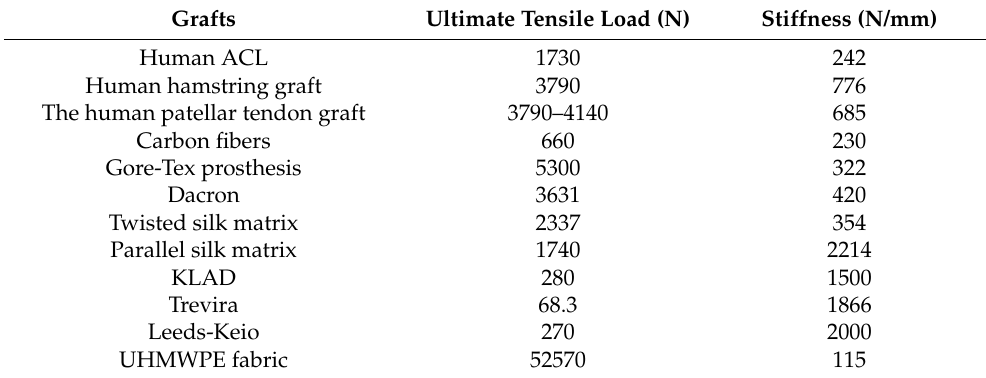
Table 12. Mechanical properties of materials for synthetic grafts compared to normal ACL [168]. Grafts Ultimate Tensile Load (N) Human